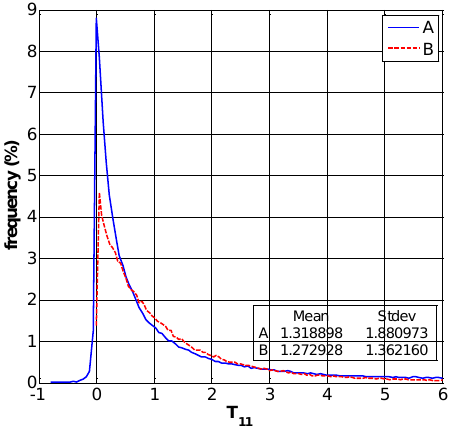
Figure 4. Histogram of element T 11 of coherency matrix calculated by (A) backward resample and (B) integrate